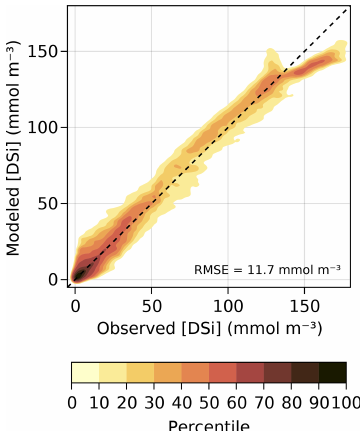
Figure A1. Quantiles of the cumulative joint probability density functions of modeled and observed dissolved Si concentrations for the parallel Si cycling model. Darker colors indicate high density of data, such that n % of the modeled and observed data lie outside of the n th percentile contour. The closer the darker contours are to the 1 : 1 black dashed line, the better the